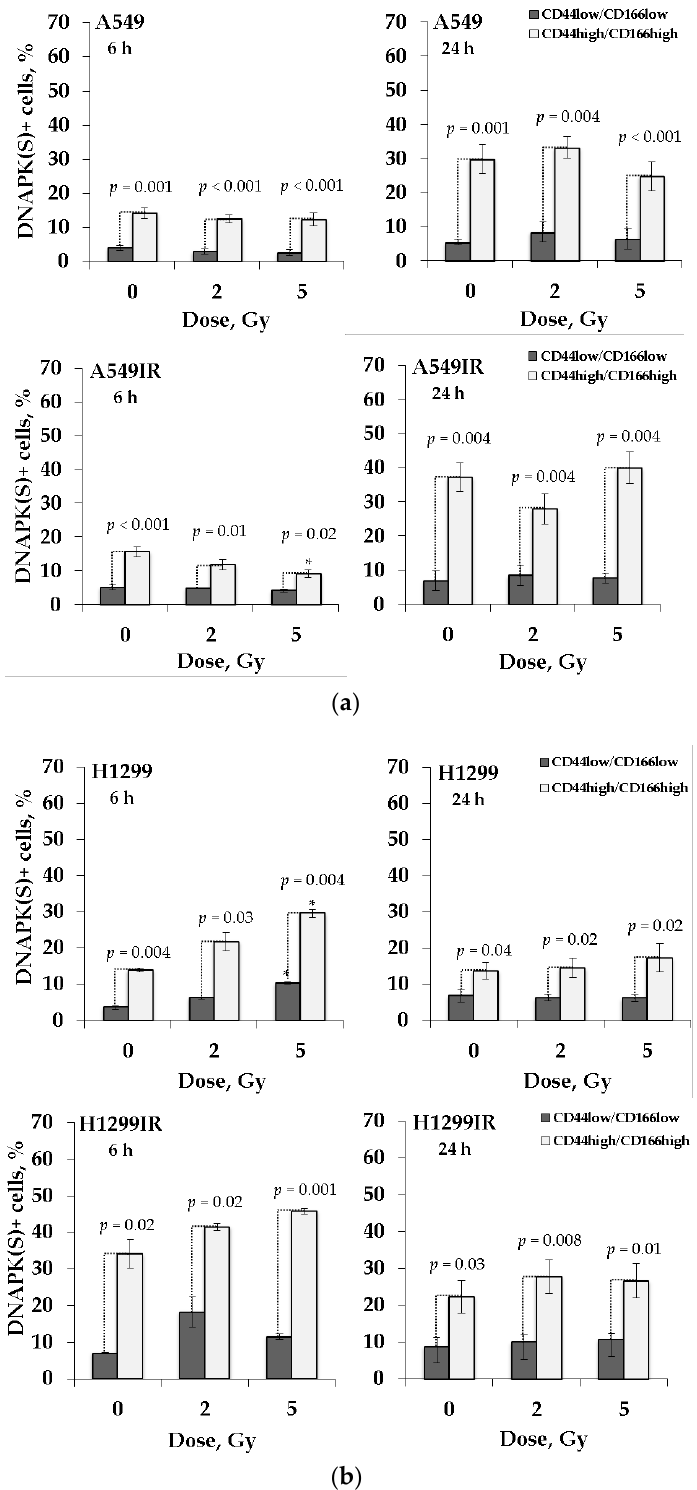
Figure 7. The proportion of DNA-PK(S) positive cells in the CD44low/CD166low and CD44high/CD166high populations of MFR-surviving and their parental NSCLC cells 6 h and 24 h after exposure to 2 Gy and 5 Gy of X-ray: A549IR and A549 cells ( a ); H1299 and H1299IR cells ( b ). * p < 0.05. Data are means ± SEM of more than three independent experiments.